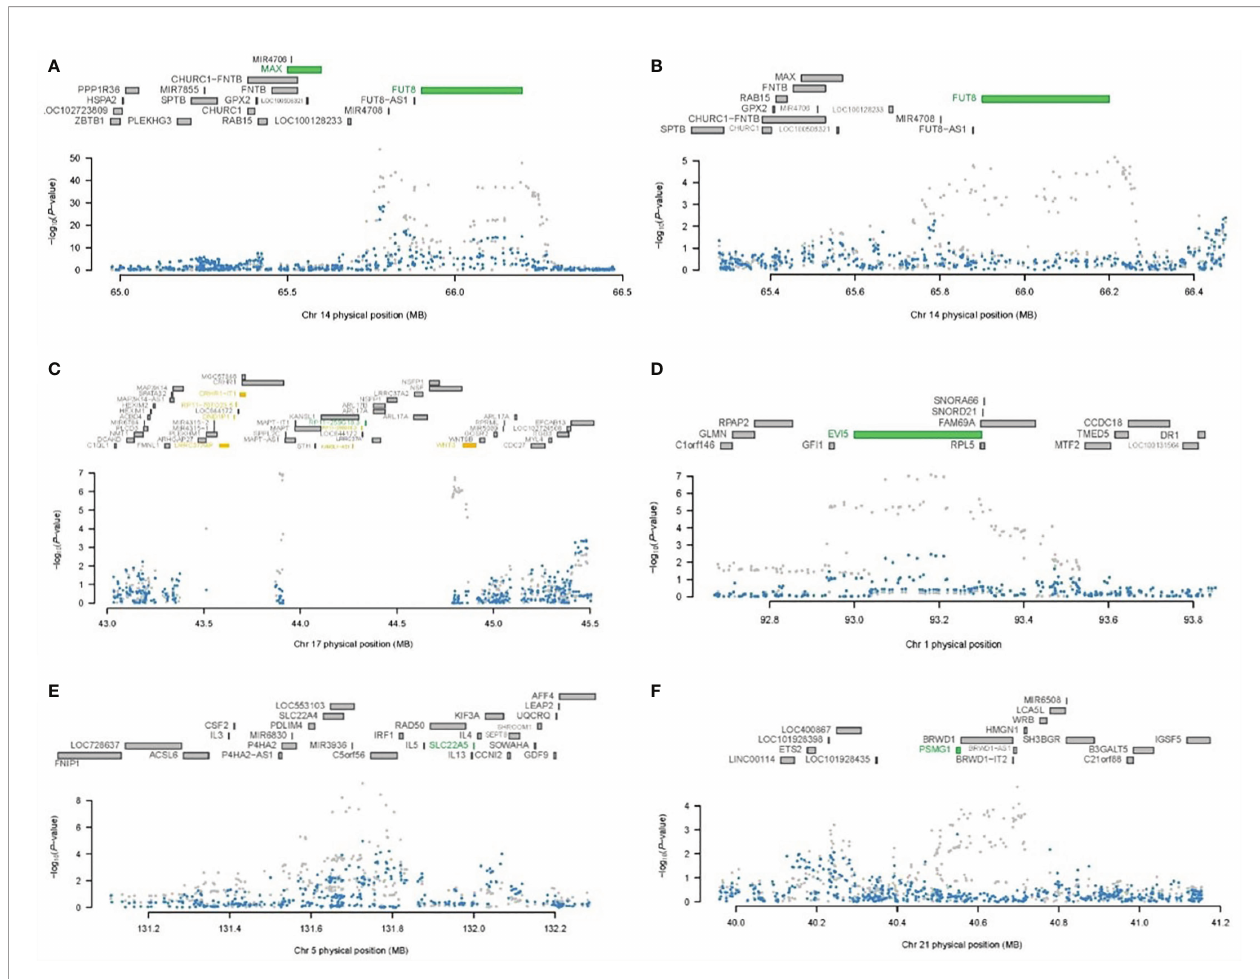
FIGURE 5 | Regional association of TWAS hits. (A) Chromosome 14 regional association plot for GP3 in skeletal muscle. (B) Chromosome 14 regional association plot for GP14 skeletal muscle. (C) Chromosome 17 regional association plot for GP10 in the small intestine terminal ileum. (D) Chromosome 1 regional association plot for GP3 in skeletal muscle. (E) Chromosome 5 regional association plot for GP3 in the small intestine terminal ileum. (F) Chromosome 21 regional association plot for GP19 in brain hypothalamus. The top panel in each plot highlights all genes in this 1-Mb window. The marginally signi fi cant genes identi fi ed by TWAS are colored in orange, and the jointly signi fi cant genes are highlighted in green. The bottom panel shows a Manhattan plot of the GWAS data before (grey) and after (blue) conditioning on the predicted expression of the green